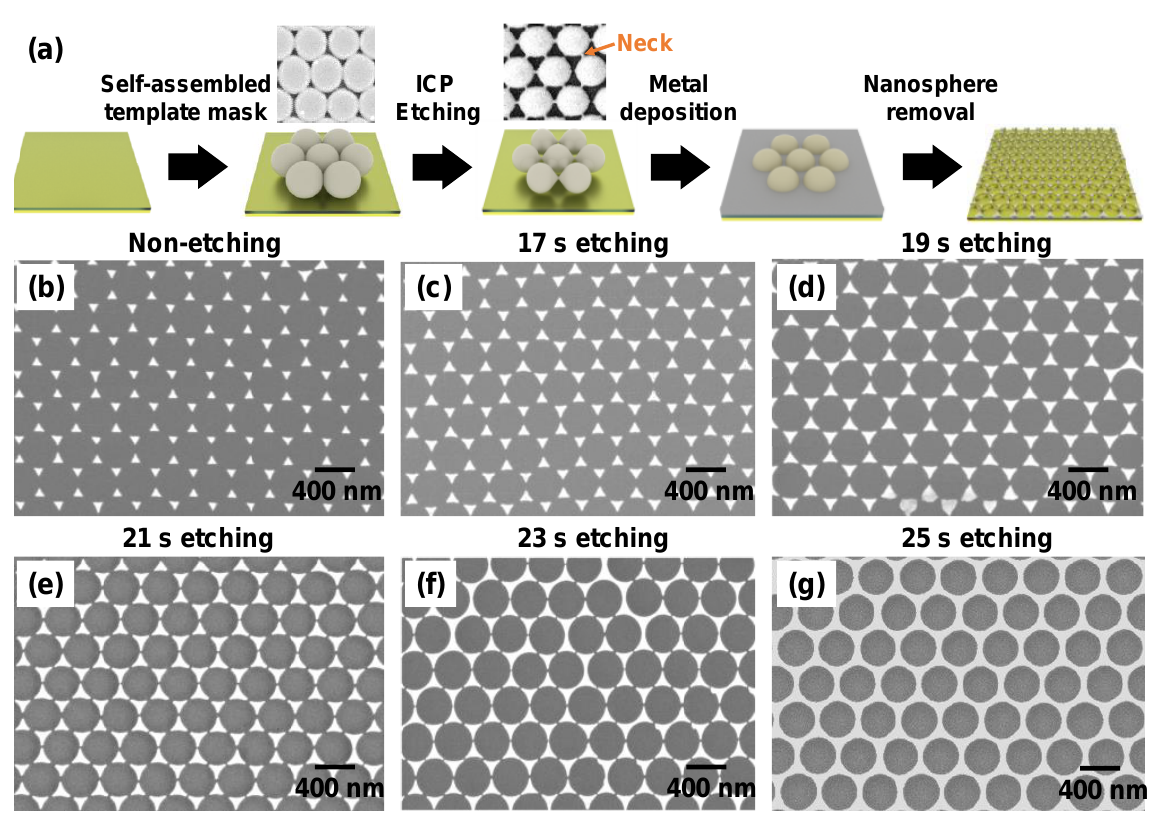
Figure 3. ( a ) Schematic fabrication processes for the Ag metasurfaces with ICP etching. Typical SEM images of the templated masks are comparatively illustrated before and after ICP etching. ( b – g ) SEM images of the fabricated Ag metasurfaces without and with ICP etching, respectively.